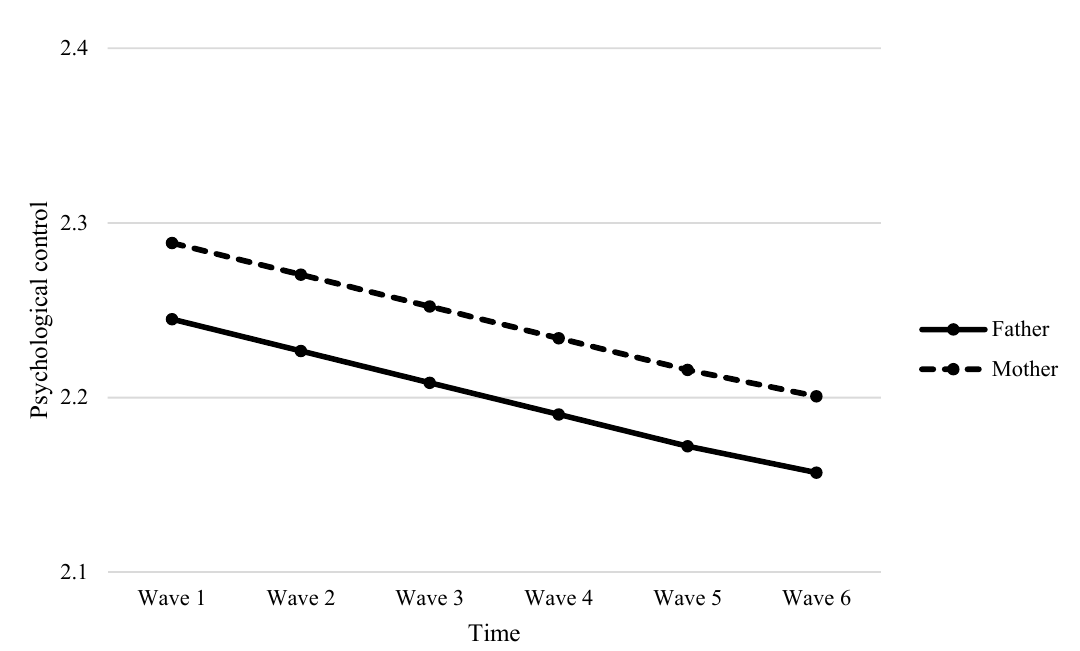
Figure 3. Fitted trajectories of psychological control of mothers and fathers. The figures were plotted based on Model 4b shown in Table 6.